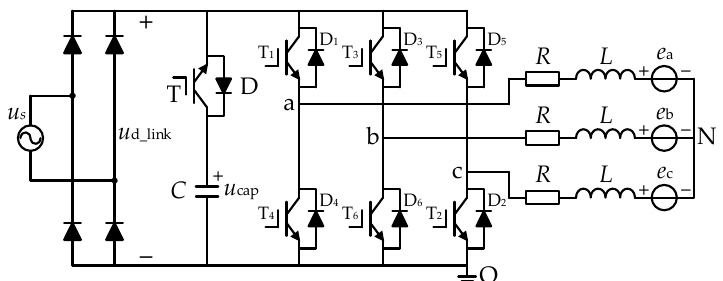
Figure 1. Topology of a brushless DC motor (BLDCM) drive system with a small DC-link capaci- tor.